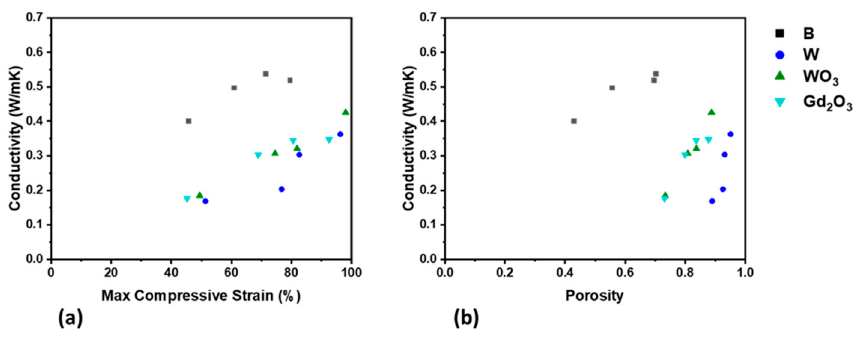
Figure 8. Thermal conductivity of 50 wt% metal- and ceramic-filled printed cylinders plotted against ( a ) porosity and ( b ) maximum compressive strain.